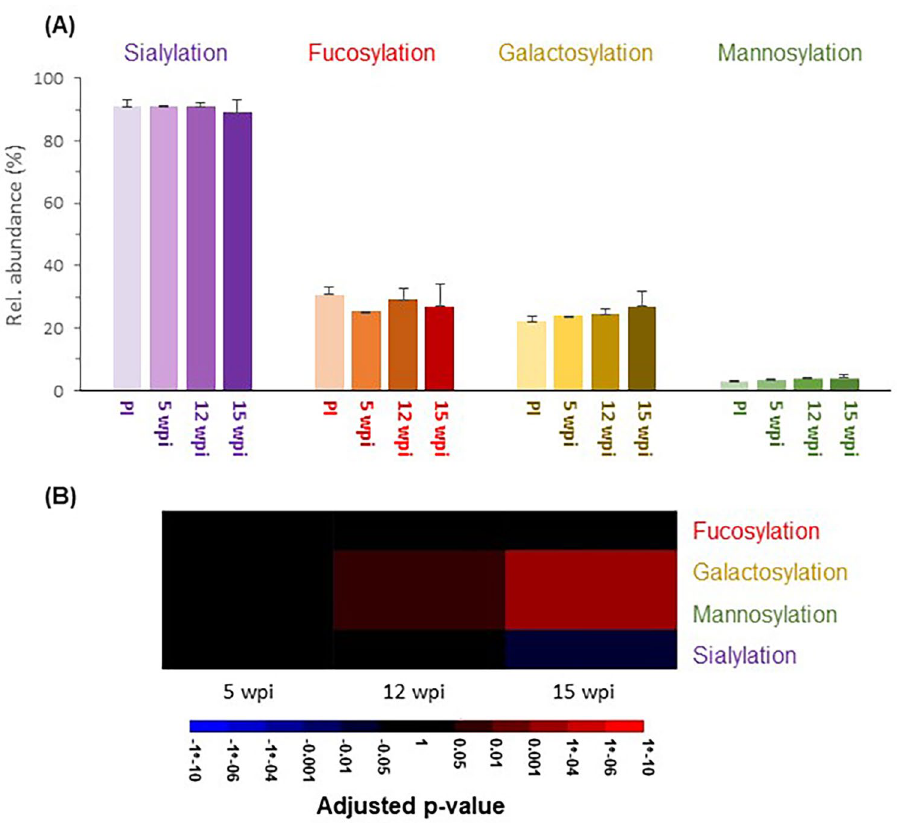
Figure 5. Changes in the major classes of rhesus macaque serum N-glycans during the course of infection with B. malayi . N-glycan content of each glycopeak in the UPLC profile was structurally characterized using a combination of UPLC-profiling, MALDI-TOF-MS and glycosidase digestions. Based on their glycan content, glycopeaks belonged to the following glycan classes: sialylated (purple), fucosylated (red), galactosylated (yellow) and/or mannosylated (green). Relative abundance (Rel. abundance) of each class of glycan was quantified by adding individual peaks areas belonging to the same class. This was done for each animal (n = 4) at each of 4 time-points: pre-infection (PI), 5 weeks post-infection (wpi), 12 wpi and 15 wpi. Results of this analysis are shown by the bar chart ( A ). The relative abundance of each glycan class was averaged for all animals and shown as percentages with standard deviation as error bars. Statistically significant changes in relative abundance of glycan classes in the course of the infection were estimated using linear mixed-effect models. Adjusted p -values can be found in Supplementary Table S5 online and were used to generate the heatmap ( B ). Blue color indicates a decrease in abundance and red an